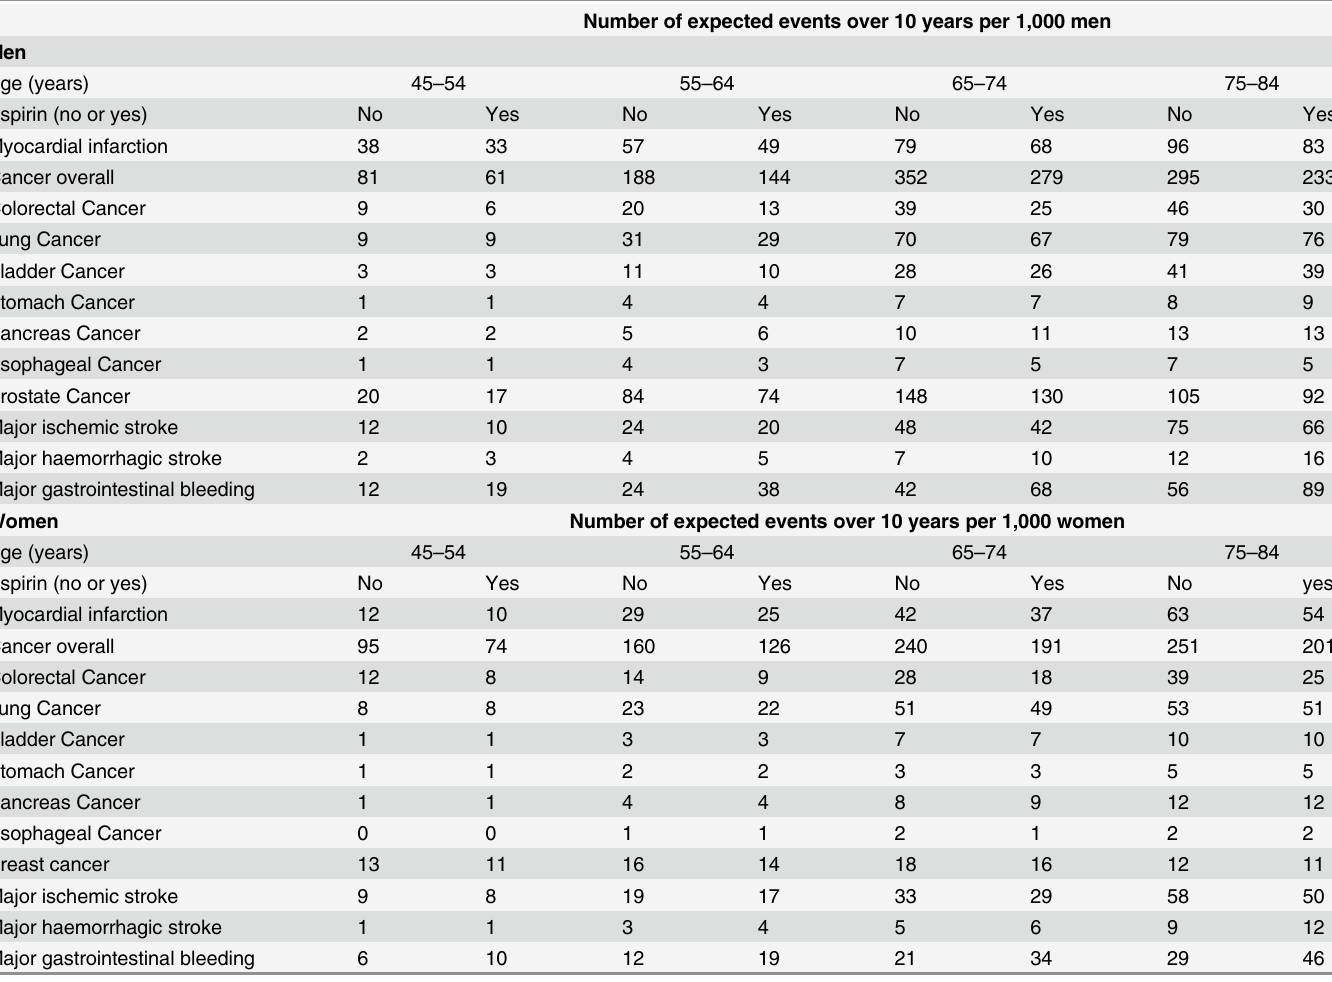
Table 3. Expected number of events without and with aspirin prevention in men and women.